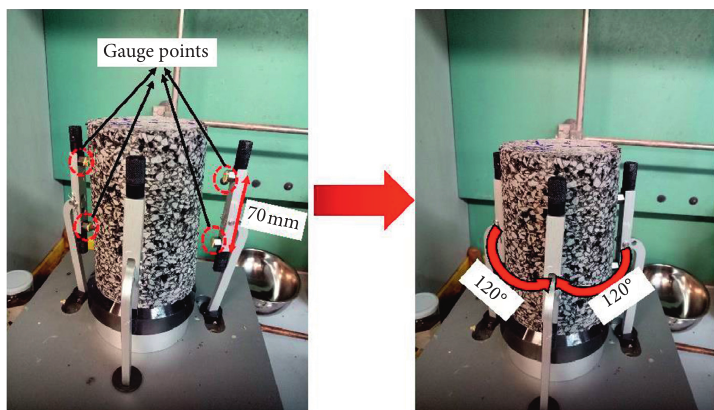
Figure 5: Standard glued-gauge-point (GGP)